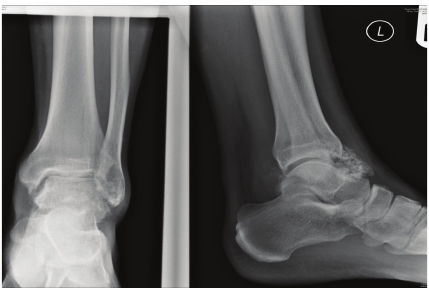
Figure 1: Preoperative radiographs showing a large speculated mass of calcified loose bodies.